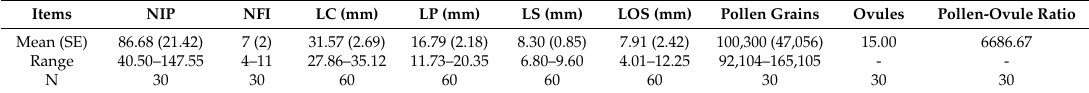
Table 1. Floral characteristics of Schima superba Garden. et Champ